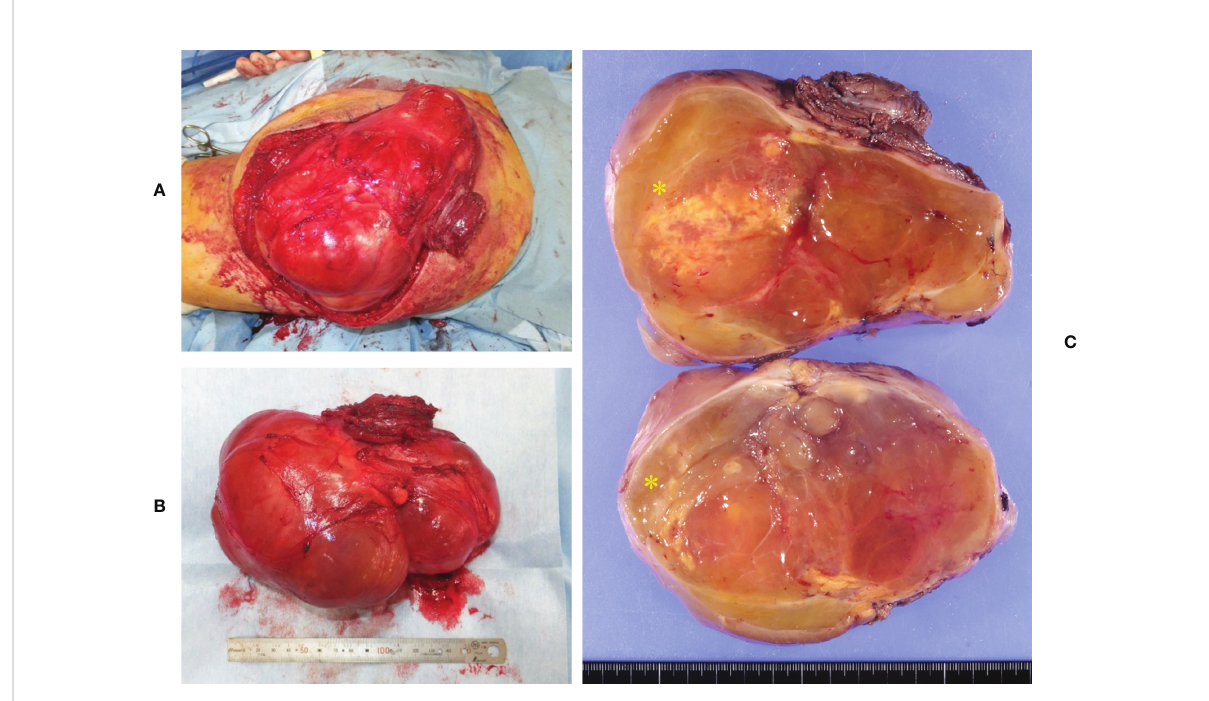
FIGURE 3 Intraoperative and pathological fi ndings of the resection specimen. The tumor was located inside the gluteus maximus (A) . Macroscopically, the tumor measured 16 × 15 × 12 cm in size (B) . The tumor consisted of large myxoid components and small fatty components (yellow asterisk) (C)